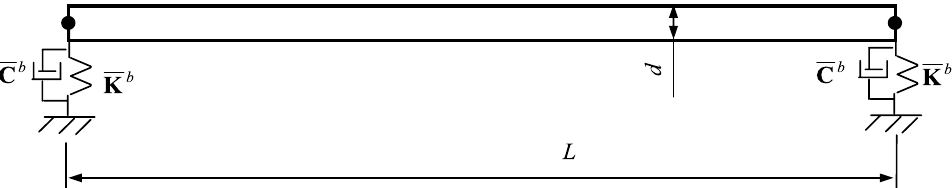
Fig. 2. Rotor-bearing